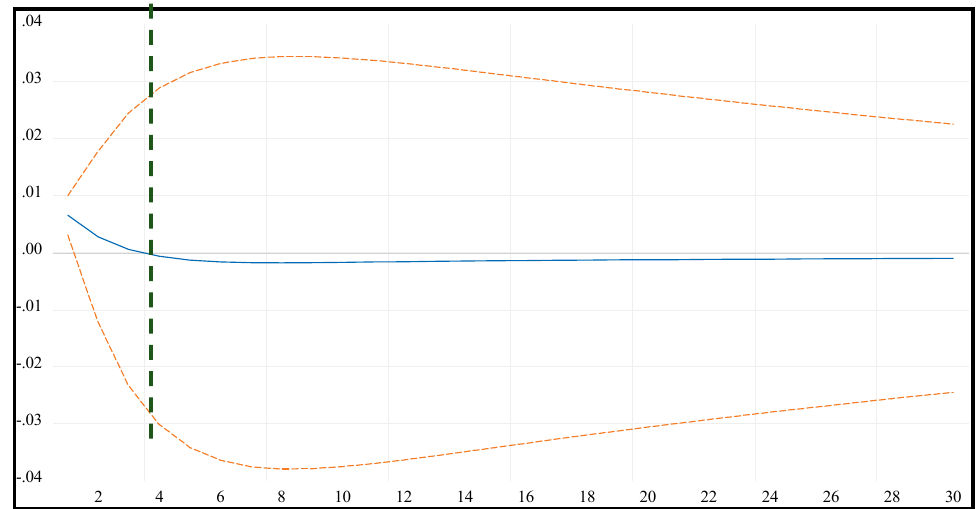
Figure 5. Response of LCO 2 to RES using structural VAR factor.